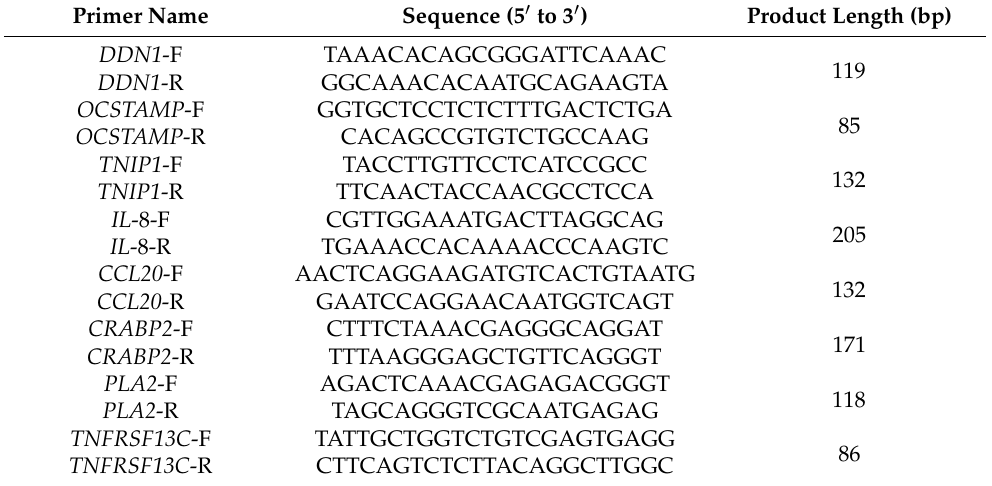
Table 2. The primers used in qPCR validation.